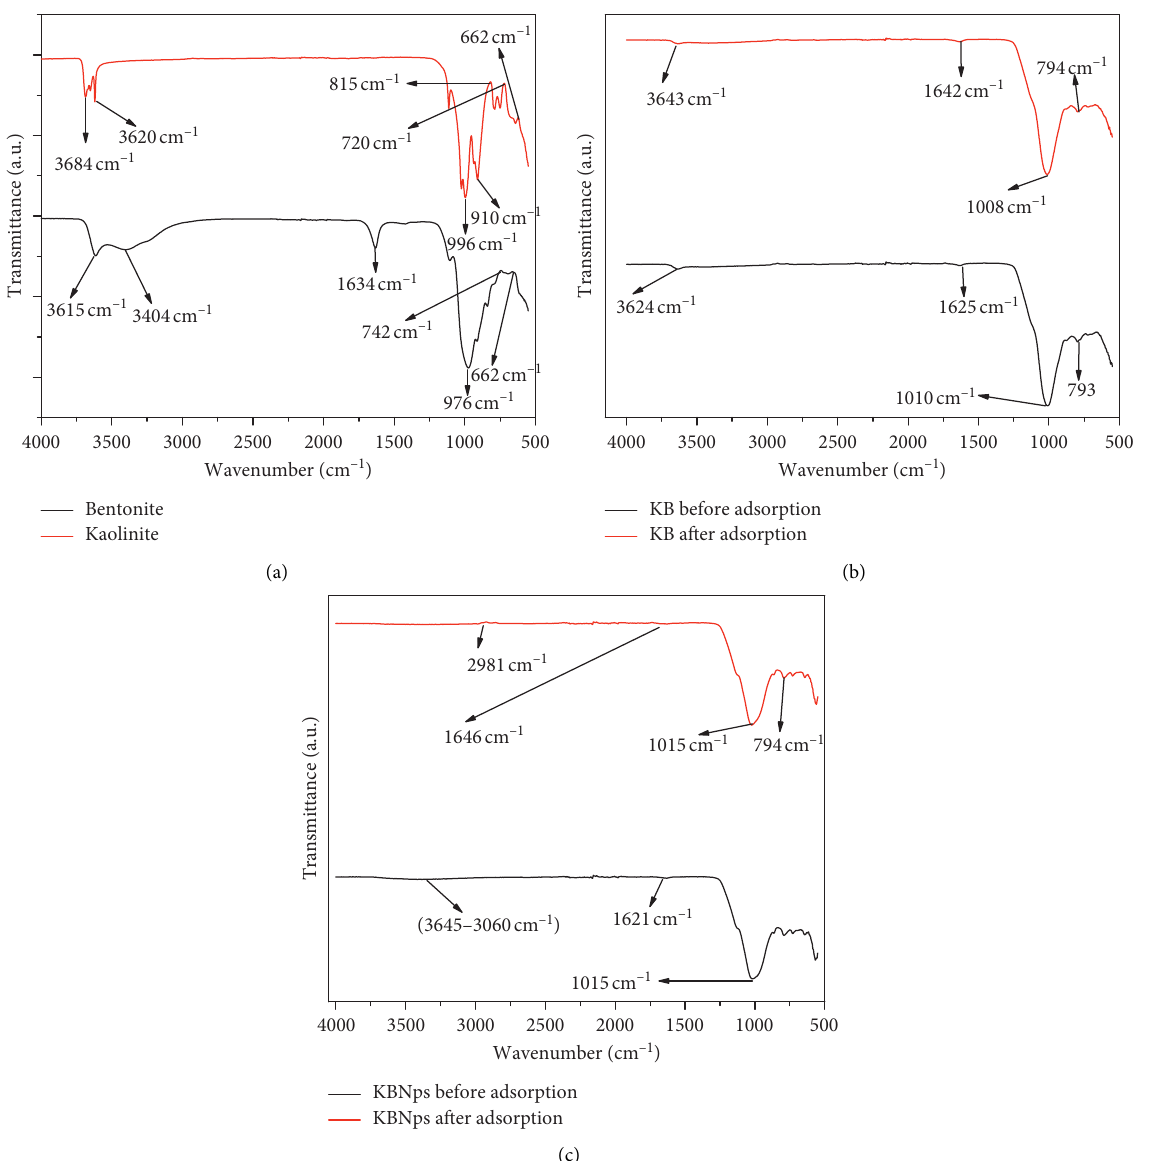
Figure 3: FTIR spectra for (a) bentonite and kaolinite clays, (b) KB composites, and (c) KBNPs composites before and after the adsorption